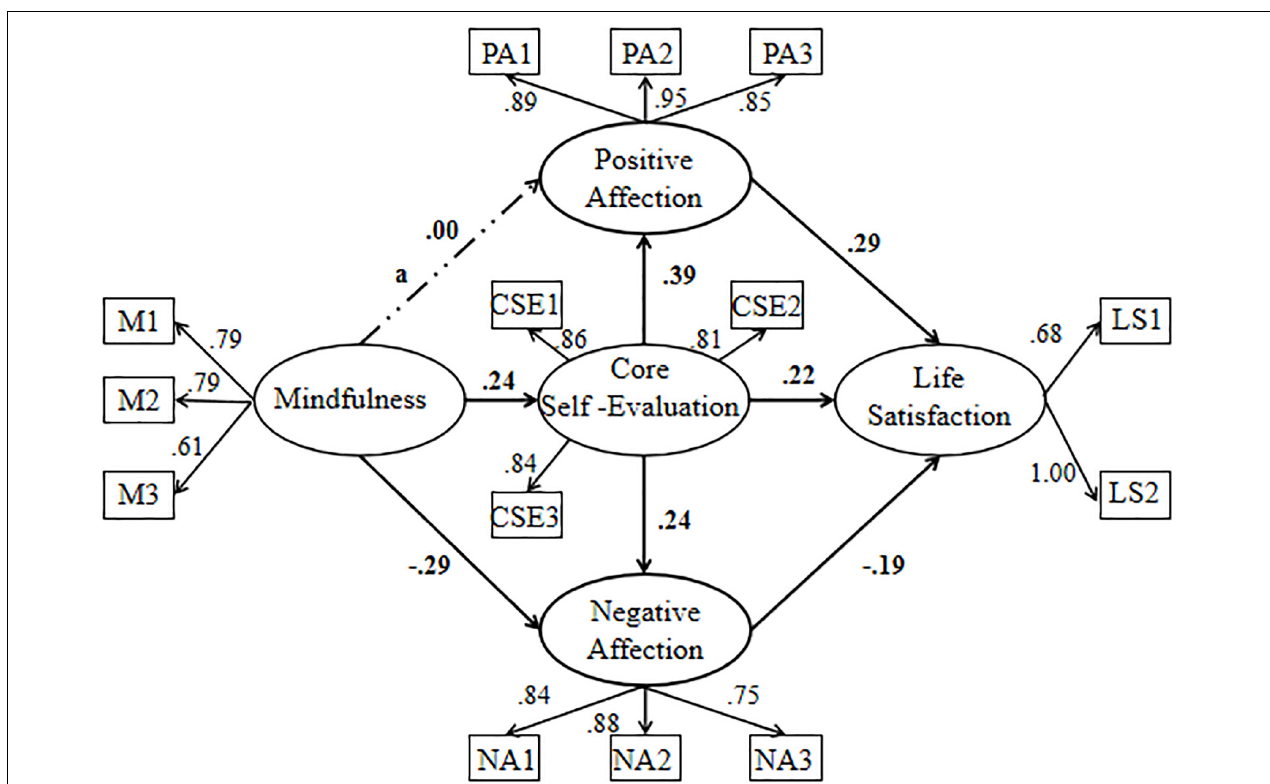
FIGURE 1 | The chain mediation model ( N = 991). M1, M2 and M3 are three parcels of mindfulness. LS1 and LS2 are two parcels of life satisfaction. PA1, PA2 and PA3 are three parcels of positive affect. CSE1, CSE2 and CSE3 are three parcels of core self-evaluation. NA1, NA2 and NA are three parcels of negative affect.